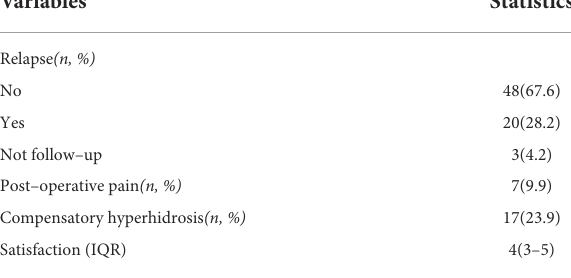
TABLE 4 Complications and satisfaction of participants after